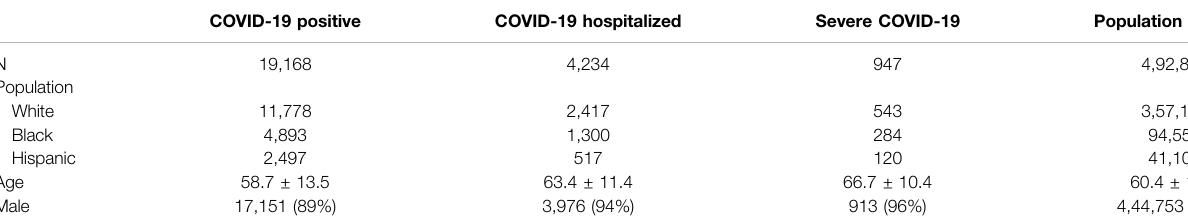
TABLE 1 | Descriptive statistics of MVP participants contributing to the association between genetic variants and COVID-19 outcomes.